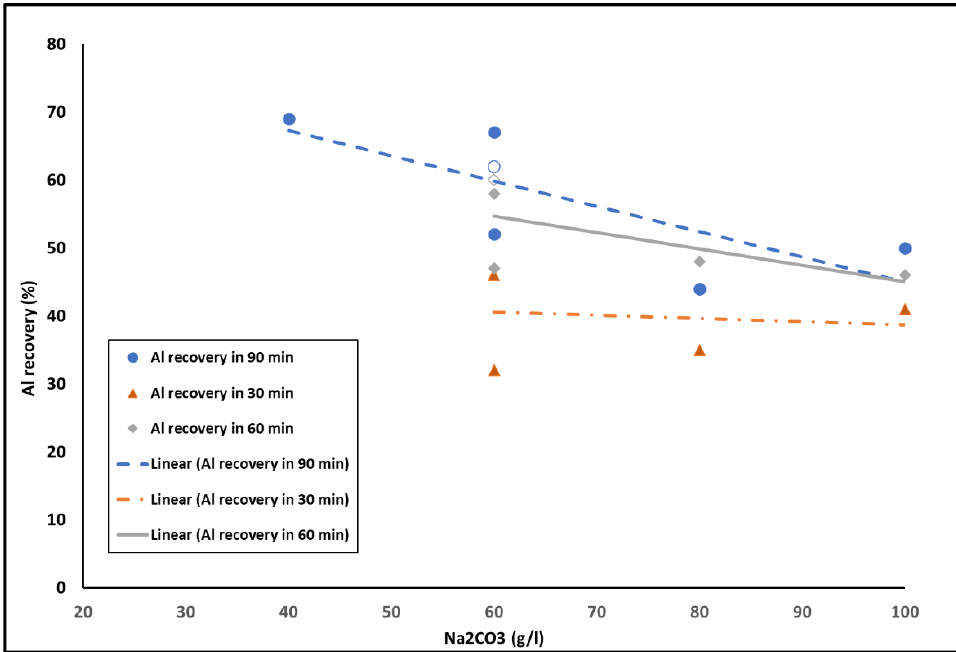
Figure 6 . Comparison of Al recovery at various time points from leach curves of tests no. 1, 2, 3, 4, and 6.